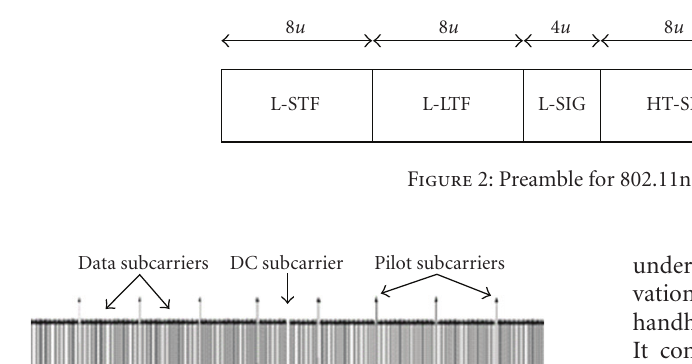
Figure 1: OFDM block diagram.